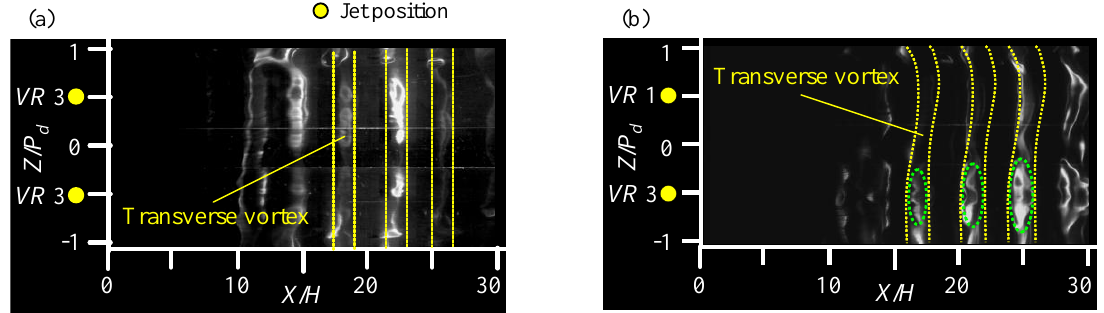
Fig. 7 Flow visualization at X-Z section  Re = 300, F